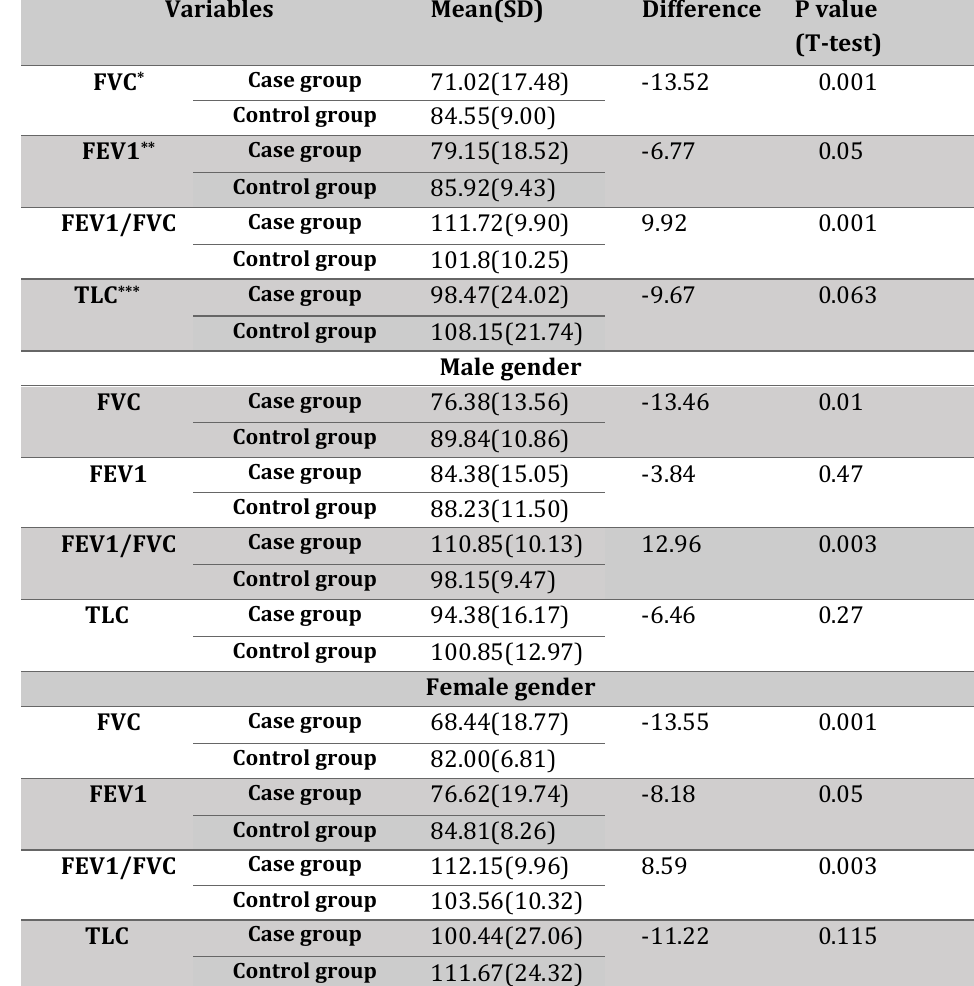
Table 2. Comparison of means of respiratory findings among study participants according to their gender and